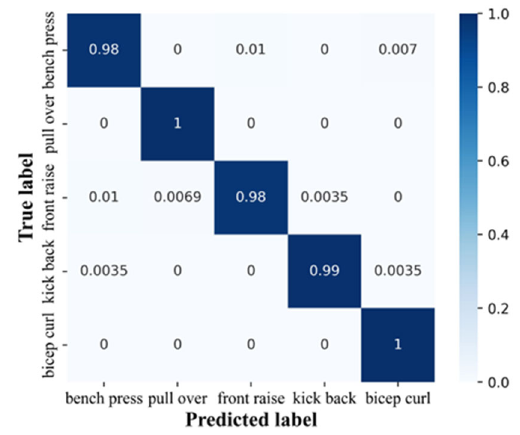
Table 1. Recognition of exercise types.